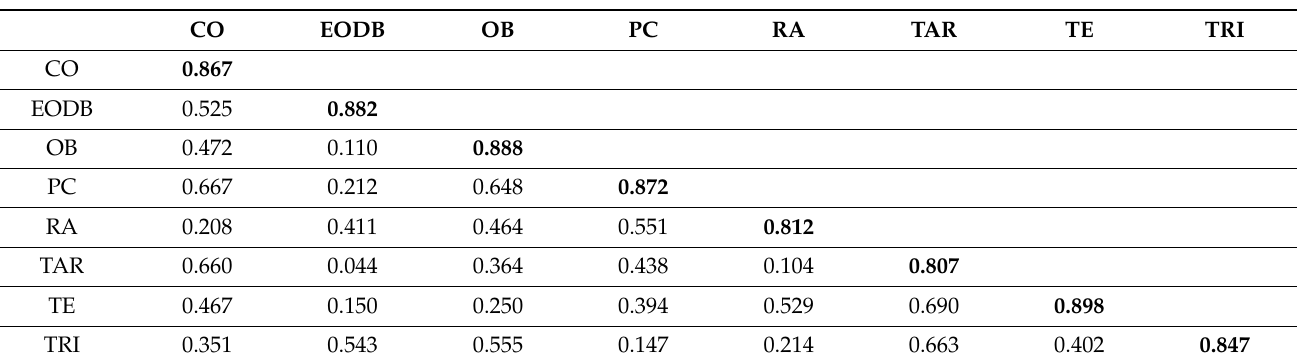
Table 6. Fornell–Larcker Scale.